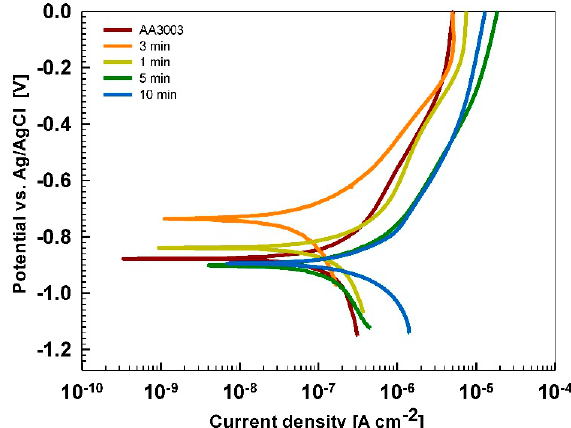
Figure A4. Potentiodynamic polarization curves recorded in simulated acid rain for AA3003 samples cleaned using 2% SurTec ® 132 and 0.5% SurTec ® 089 at 40 ◦ C for di ff erent immersion times.